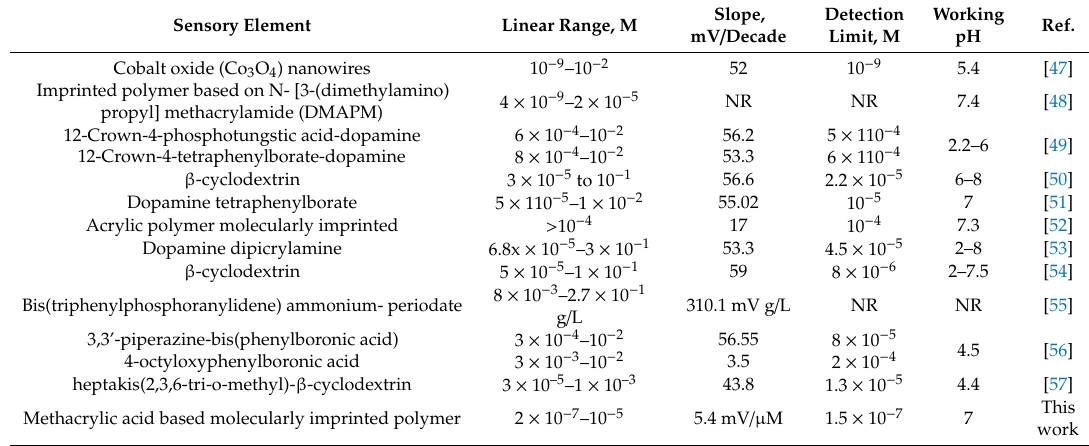
Table 3. General characteristics of some potentiometric dopamine membrane sensors. Sensory